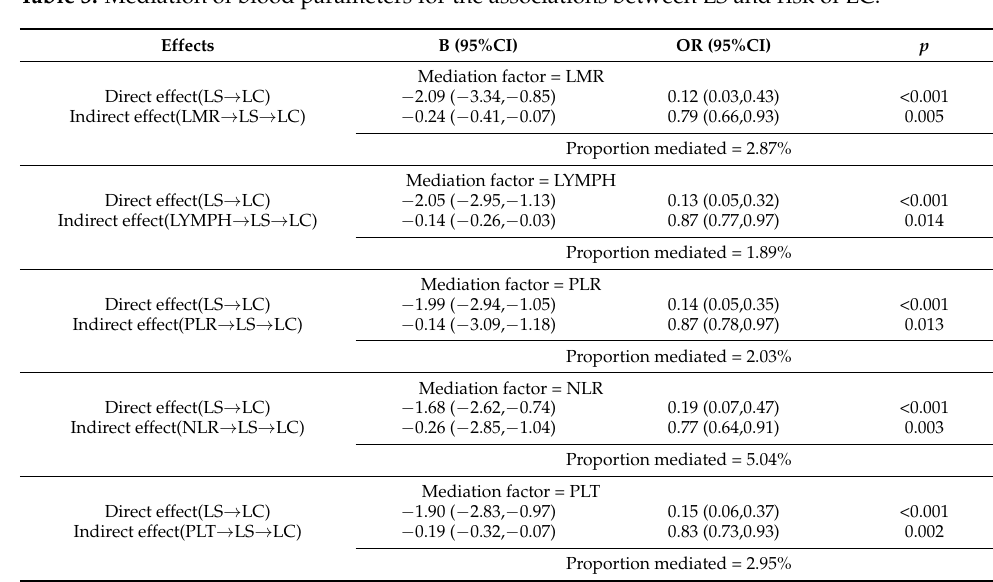
Figure 3. Selection of differential lipid between LC and controls. ( A ) Lipidomics metabolic biomarkers of RF classification. ( B ) Plot of the predictive accuracy of biomarker models (RF). ( C ) ROC curve analysis for biomarkers. ( D ) Forest plot. Table 3. Mediation of blood parameters for the associations between LS and risk of